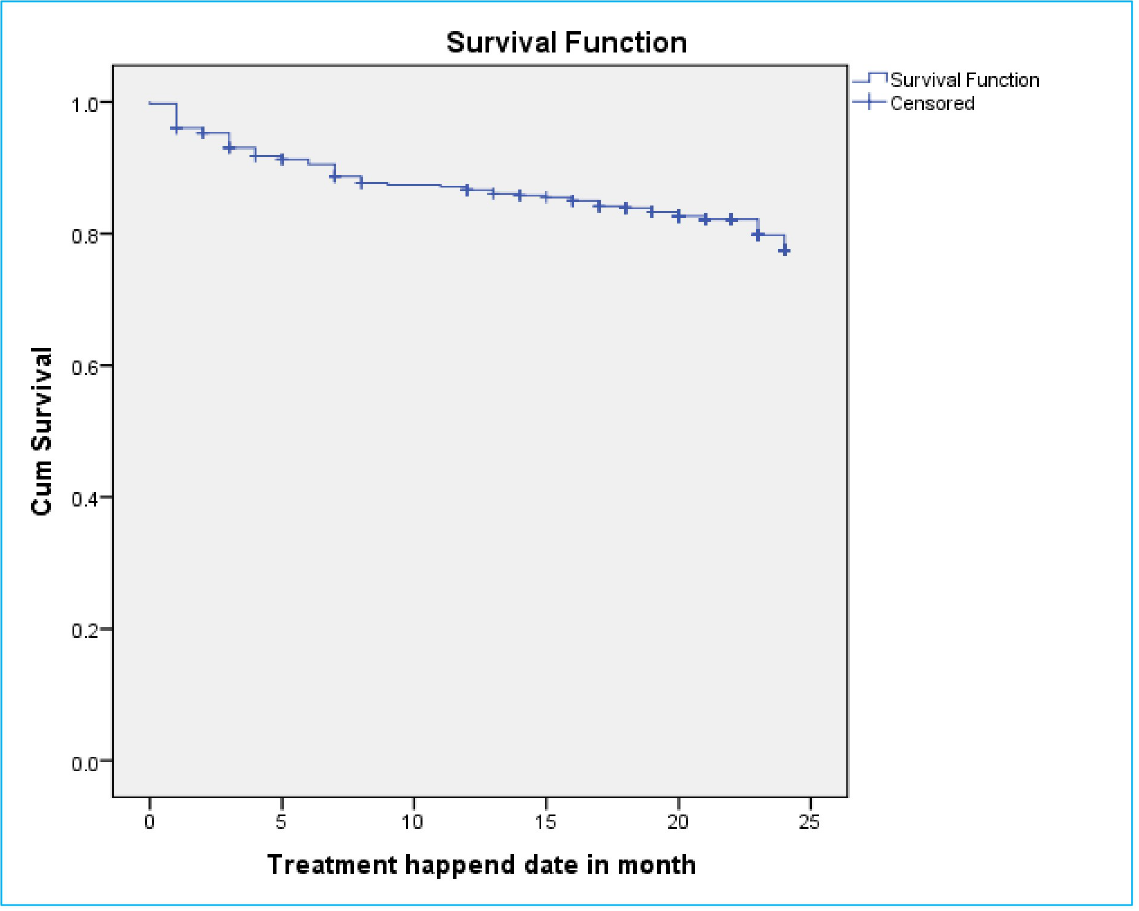
Fig 2. Kaplan–Meier survival estimate for mortality of drug resistance tuberculosis infected patents in Oromia region, Ethiopia, 2020.